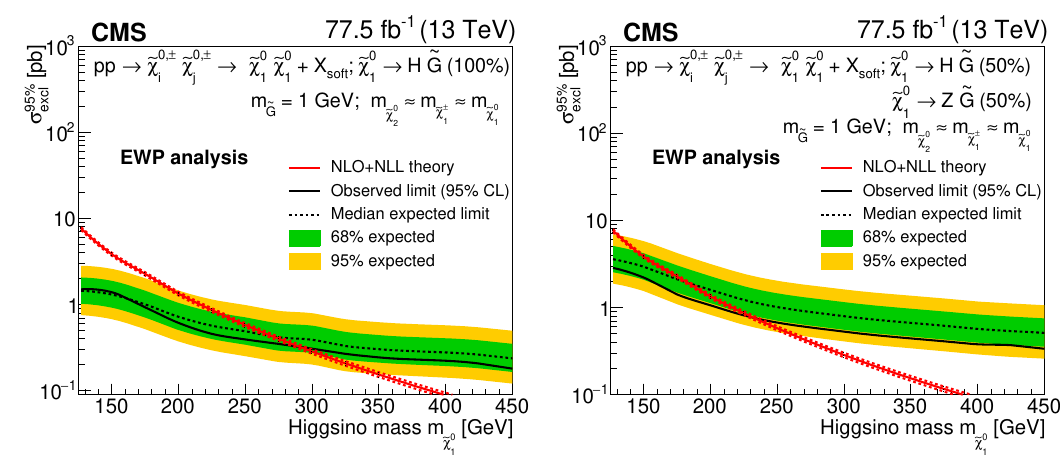
Figure 5 . The observed 95% CL upper limits on the production cross section for higgsino-like chargino-neutralino production are shown for the EWP analysis. We present limits in the scenario (cid:31) 0 ! H where the branching fraction of G decay is 100% (left plot), and where the 1 and G decays are each 50% (right plot). The dotted and solid black curves represent the e expected and observed exclusion region, and the green dark and yellow light bands represent the (cid:6) 1 e e and (cid:6) 2 standard deviation regions, respectively. The red solid and dotted lines show the theoretical production cross section and its uncertainty band.